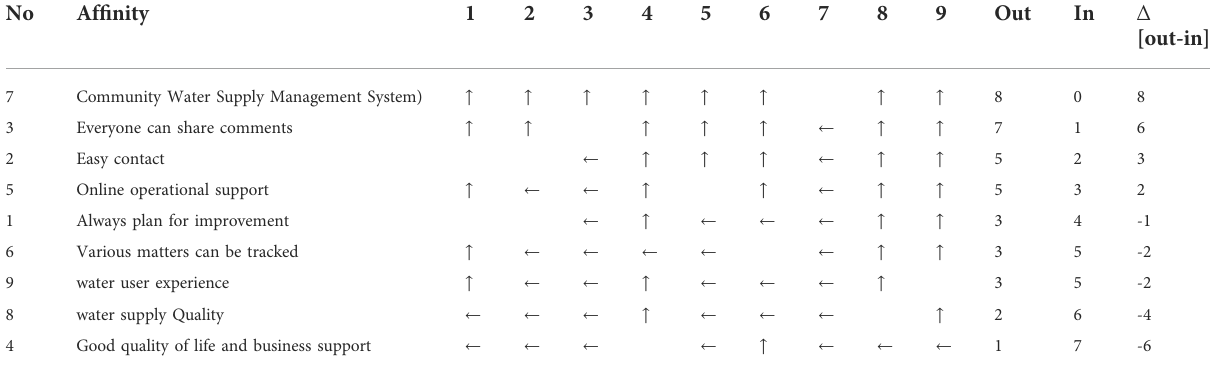
TABLE 9 Determining drivers and outcomes.